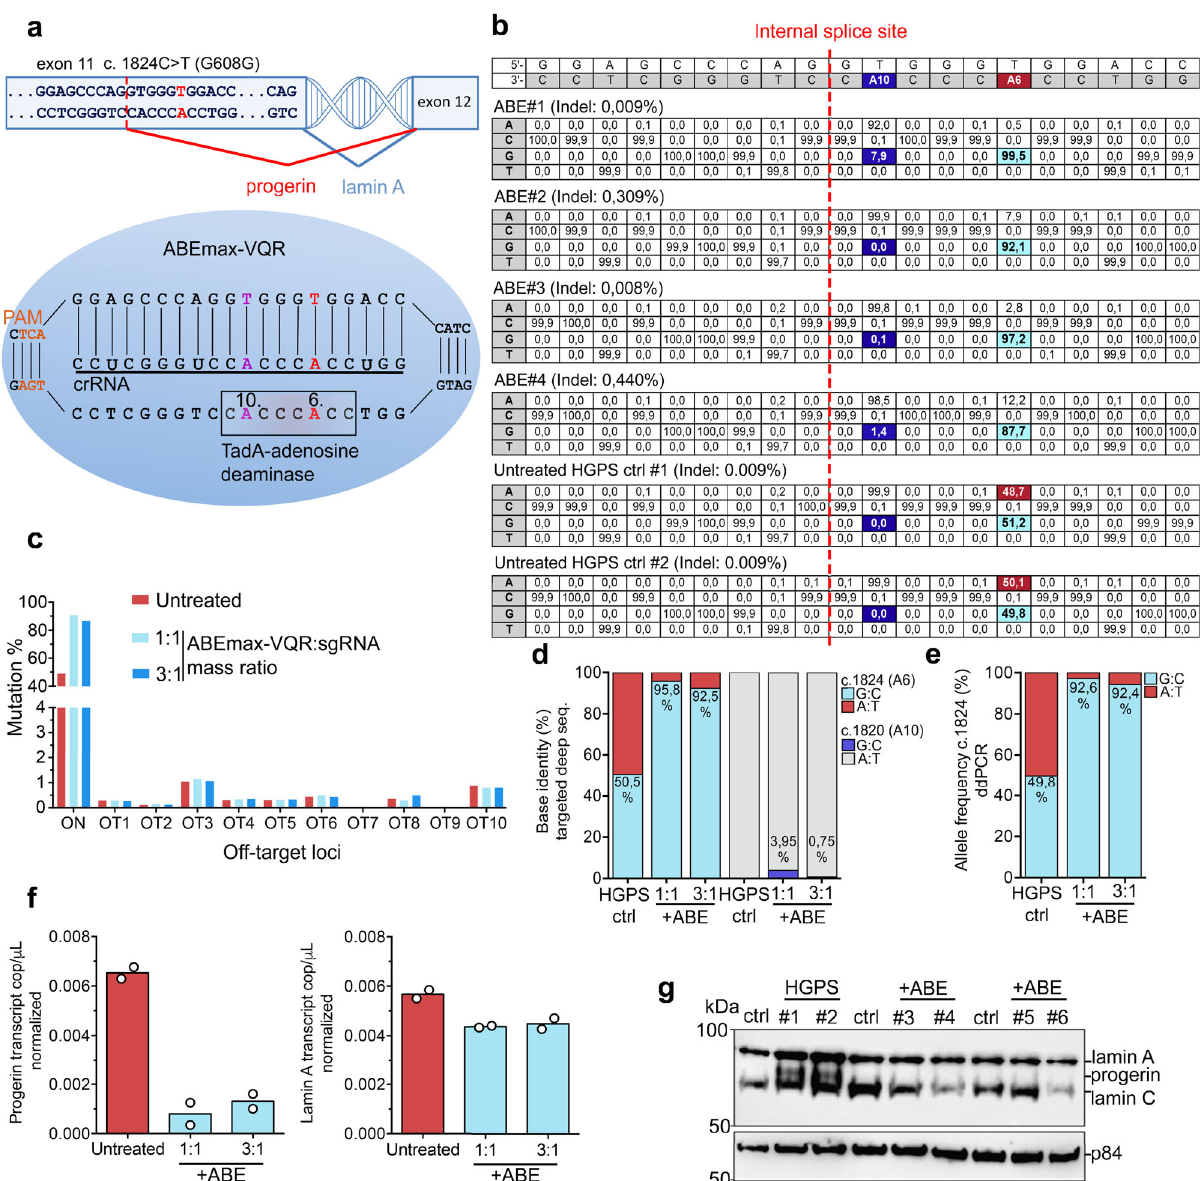
Fig. 1 ABE-mediated correction of the pathogenic HGPS mutation in patient cells. a The HGPS-causing point mutation c.1824C > T (p. G608G) was corrected by ABEmax-VQR that recognizes the PAM variant 5´-NGA-3´ (orange). The crRNA part of the sgRNA is positioning the c.1824C > T mutation at the protospacer position A6 (red) in reference to the PAM sequence. b Targeted deep-seq. of the protospacer region shows high mutation (A6, red) editing and low bystander (A10, purple) editing in transfected HGPS patient B-lymphoblasts (#1 – 2, ABE to sgRNA ratio 1:1, #3 – 4 ABE to sgRNA ratio 3:1, untreated HGPS ctrl #1-#2). c Targeted deep-seq. validation of potential off-target loci shows no increase in off-target mutation frequency in comparison to untreated controls (shown; 10 off-target loci, full analysis in Supplementary Fig. 2c & Fig. 3b, n = 2 independent experiments). d , e Comparison of the c.1824C allelic fraction as measured by targeted deep-seq. analysis and by a LMNA c.1824C> T ddPCR assay (red, c.1824 A:T; blue, c.1824 G:C; grey, c.1820 A:T; purple, 1820G:C). f Progerin and lamin A transcripts analyzed by ddPCR-absolute quanti fi cation (ddPCR-ABS), untreated samples are depicted in red, ABE treated samples are depicted in blue. g Detection of progerin levels by western blot in ABE-transfected HGPS patient B-lymphoblasts ( + ABE; #3, #4, ABEmax-VQR: sgRNA mass ratio 1:1 and #5, #6 ABEmax-VQR: sgRNA mass ratio 3:1), untreated HGPS patient B-lymphoblasts (HGPS #1 and #2) and unaffected sibling control B-lymphoblasts (ctrl) repeated with n = 2 independent experiments with similar results. Data are presented as mean values. Source data for ( d – g ) are provided as a Source Data fi